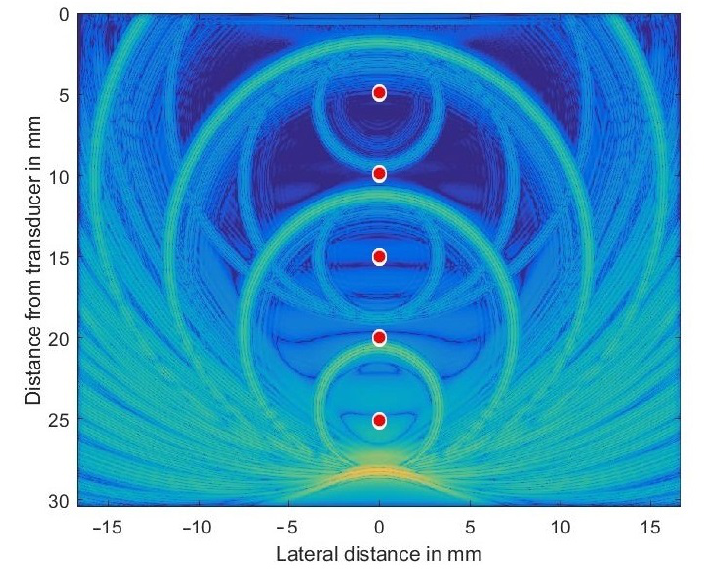
Figure 3. Ultrasonic wave’s envelope propagating downwards, focused at 35 mm and being scattered off discretely placed scatterers (indicated as red circles in exaggerated size) . The chosen colormap for the log-compressed display extends from 100 kPa (orange) to 1 Pa (in blue). Figure 4, left, shows the sound pressure amplitude vs. depth in blue on a linear scale and the expected decrease in amplitude (according to the selected medium parameters of 2.3 dB/(MHz cm)) in red. The deviation between the two graphs is attributed to the focusing action of the phased-array transducer which is focusing at a depth of 35 mm.